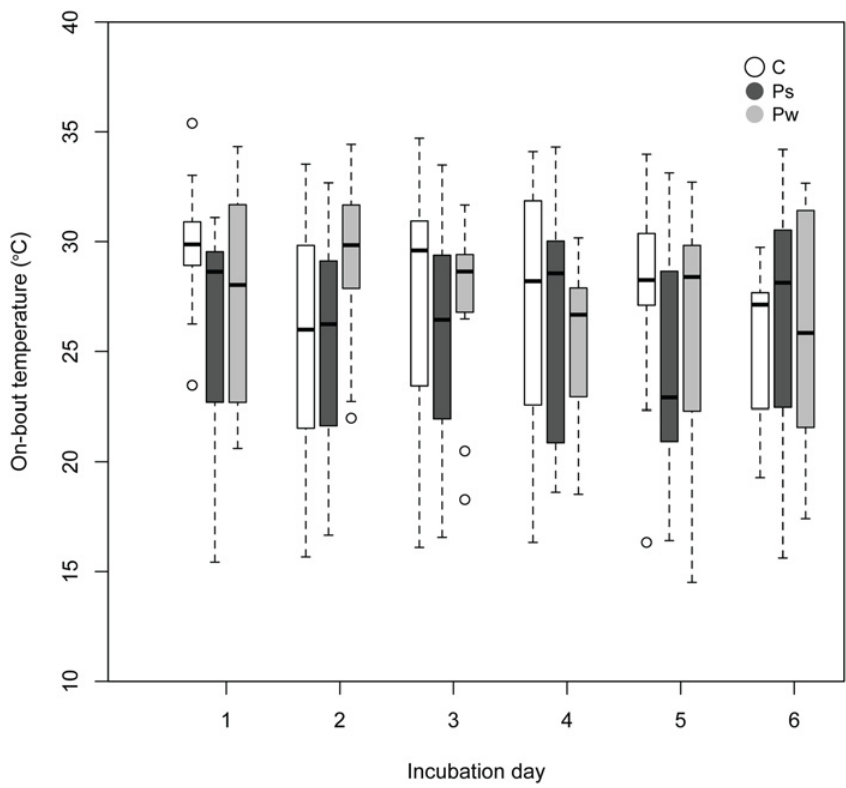
Fig 3. Box-plots of average on-bout temperature for the three treatment groups in the different incubation days. In both predator treatments temperature had a slower decline as incubation advanced compared to the control group ( P =